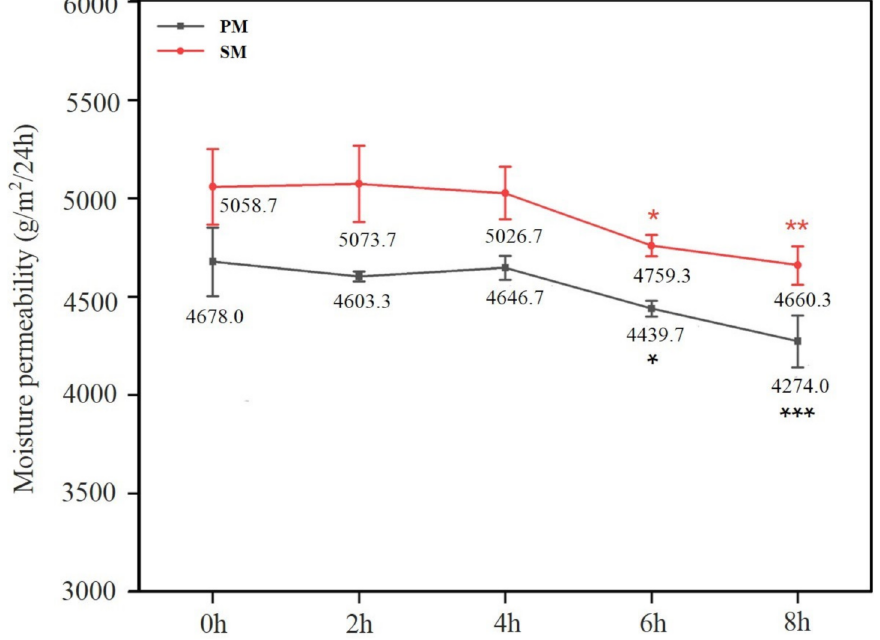
Figure 12. Results of experiments on moisture permeability. *: p value < 0.05, **: p value < 0.01, ***: p value <